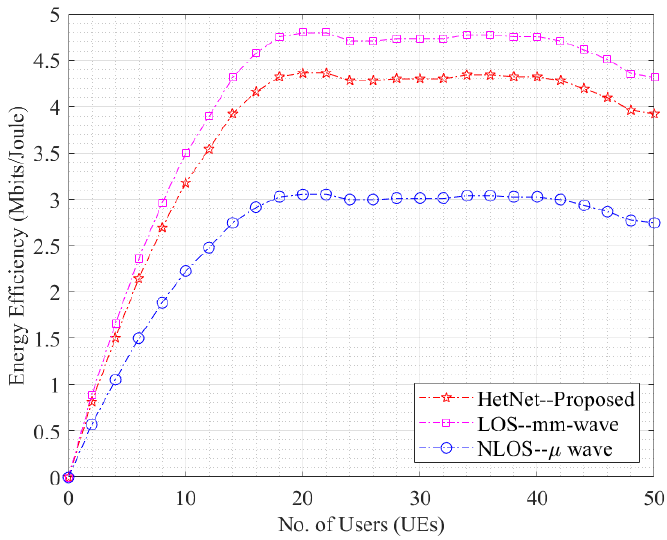
Figure 11. Energy Efficiency vs No. of UEs for LOS, NLOS and HetNet.